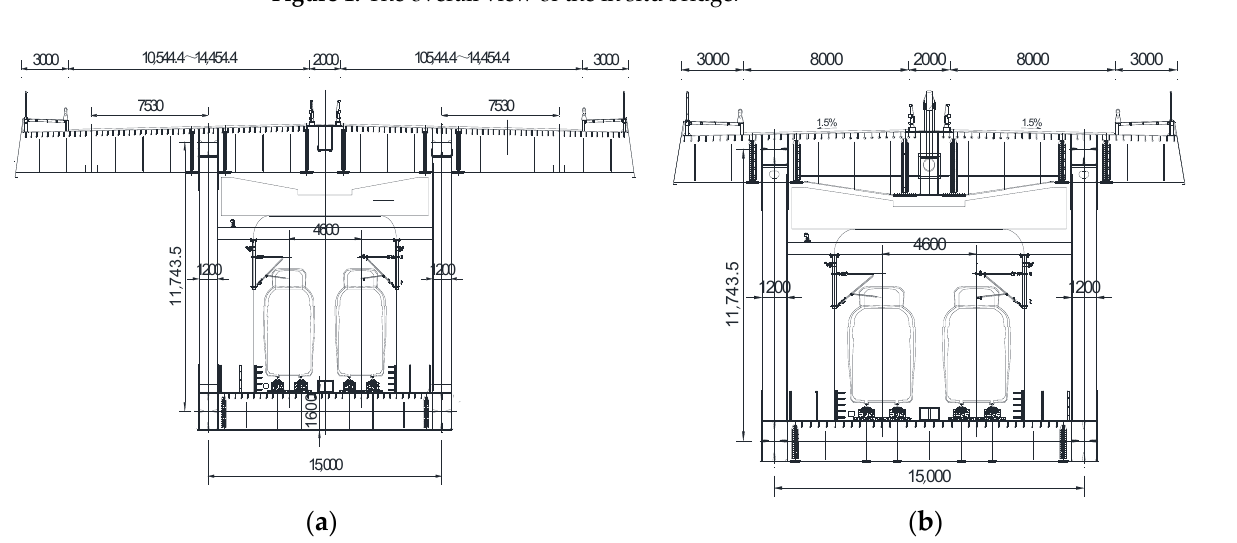
Figure 1. The overall view of the in situ bridge.